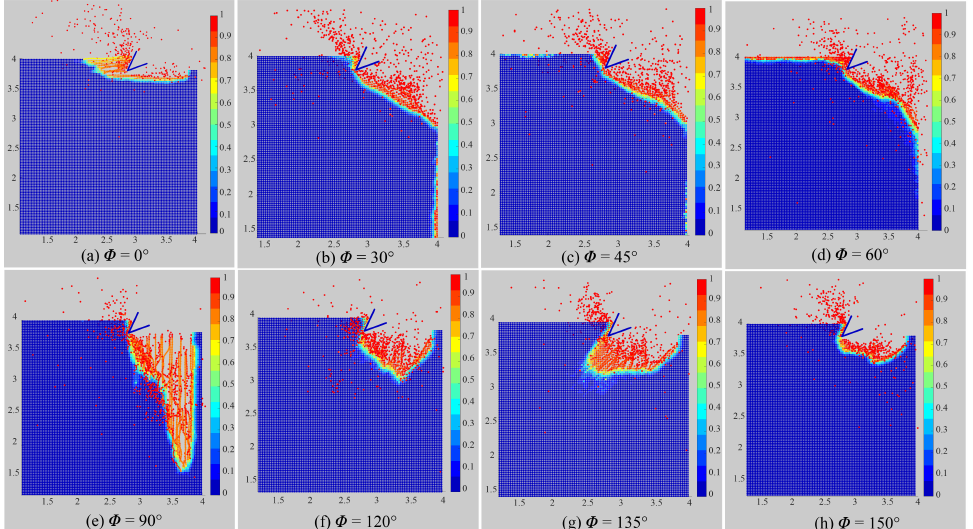
Figure 13. Chip formation for different fiber orientations (partial enlarged